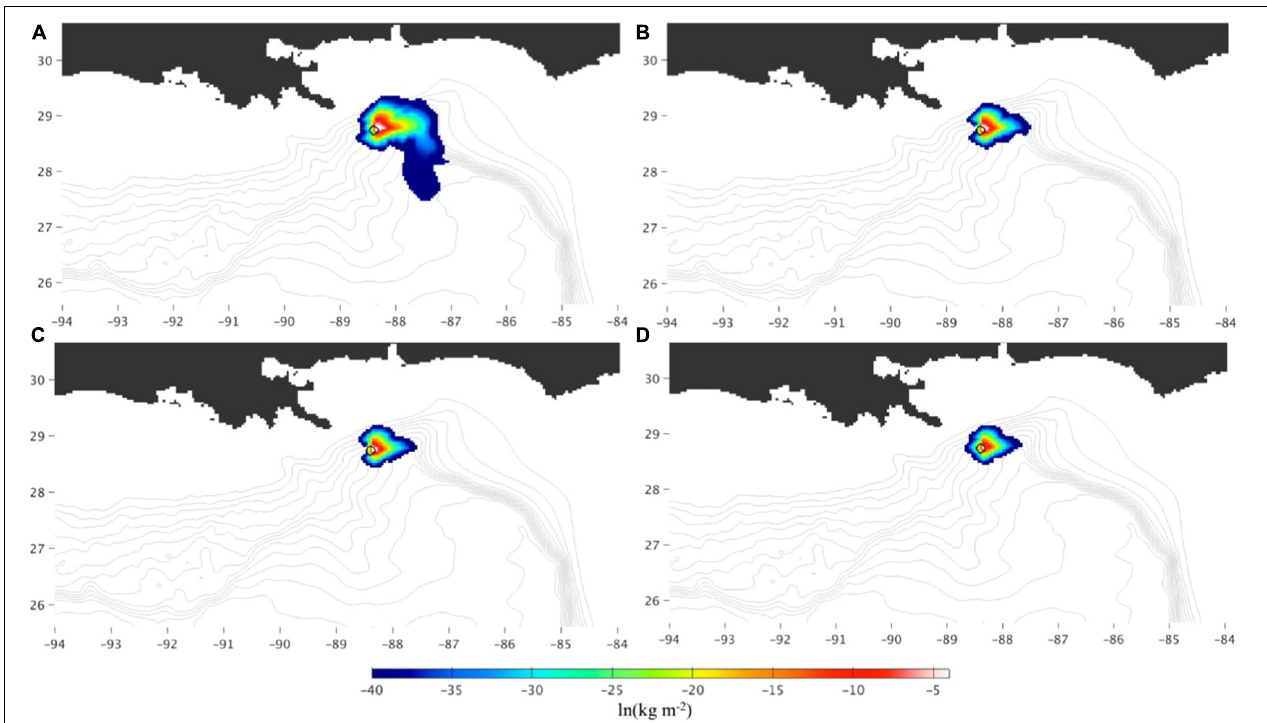
FIGURE 11 | Sediment OPAs (kg m − 2 ) from the test experiment with the fully coupled ROMS-OTWM-OPAMOD-Biogeochemical model after 30 days of simulation. The OPAs are depth-integrated. Sediment OPAs 1–4 are shown in (A–D) ,